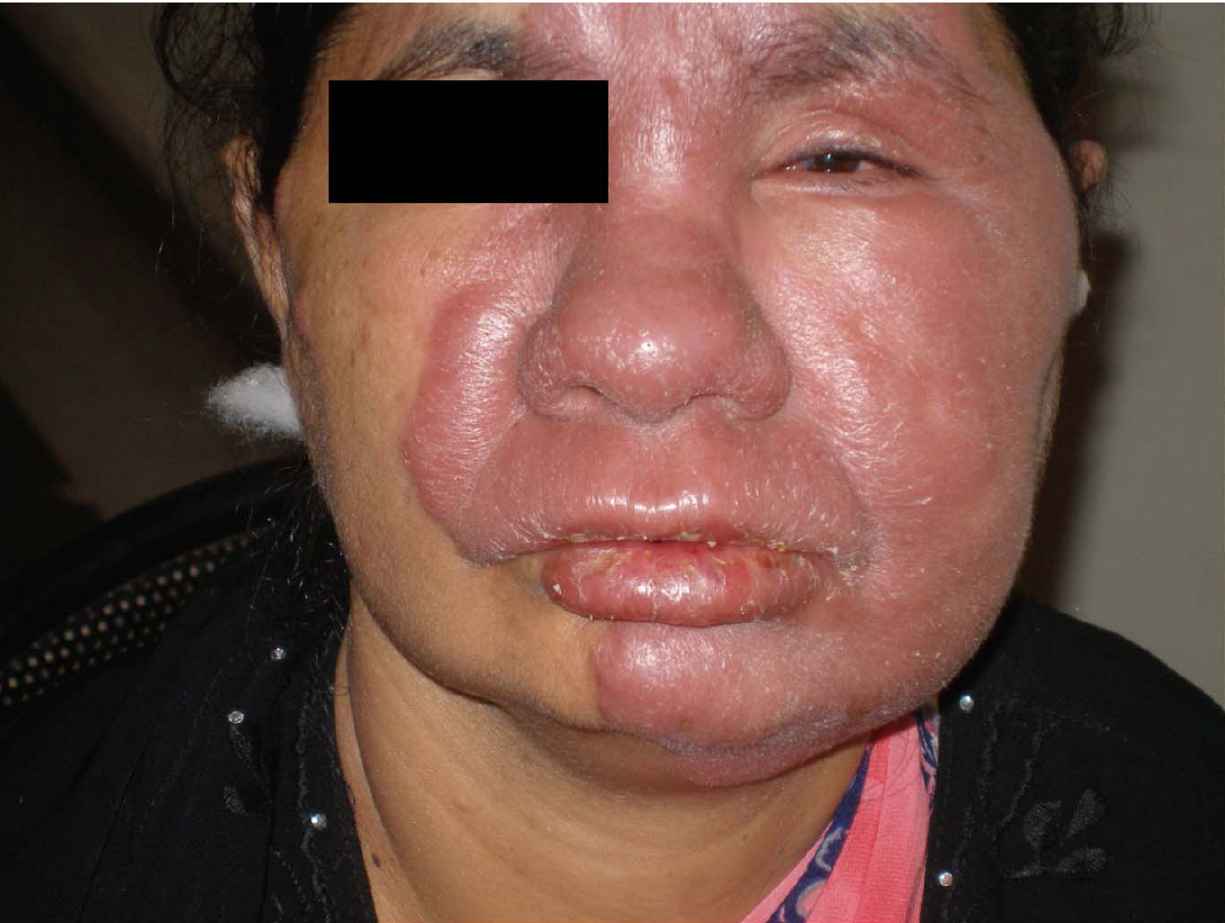
Figure 1. Patient with borderline tuberculoid leprosy face lesion with severe Type 1 Reaction. Facial patch in severe Type1 Reaction with erythema and oedema of the lesion and mild scaling.